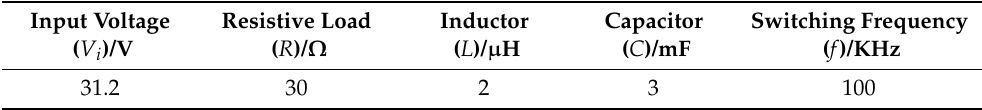
Figure 15. MATLAB/Simulink model of the solar PV module with P&O MPPT method. The experiment was carried out in 0, 0.1 s, and 0.2 s; the light irradiance was 1000 W/m 2 , 800 W/m 2 , and 600 W/m 2 ; the temperature was 25 °C; and the simulation was com ‐ pleted in 0.3 s. The application of the P&O MPPT is shown in Figures 16 and 17.